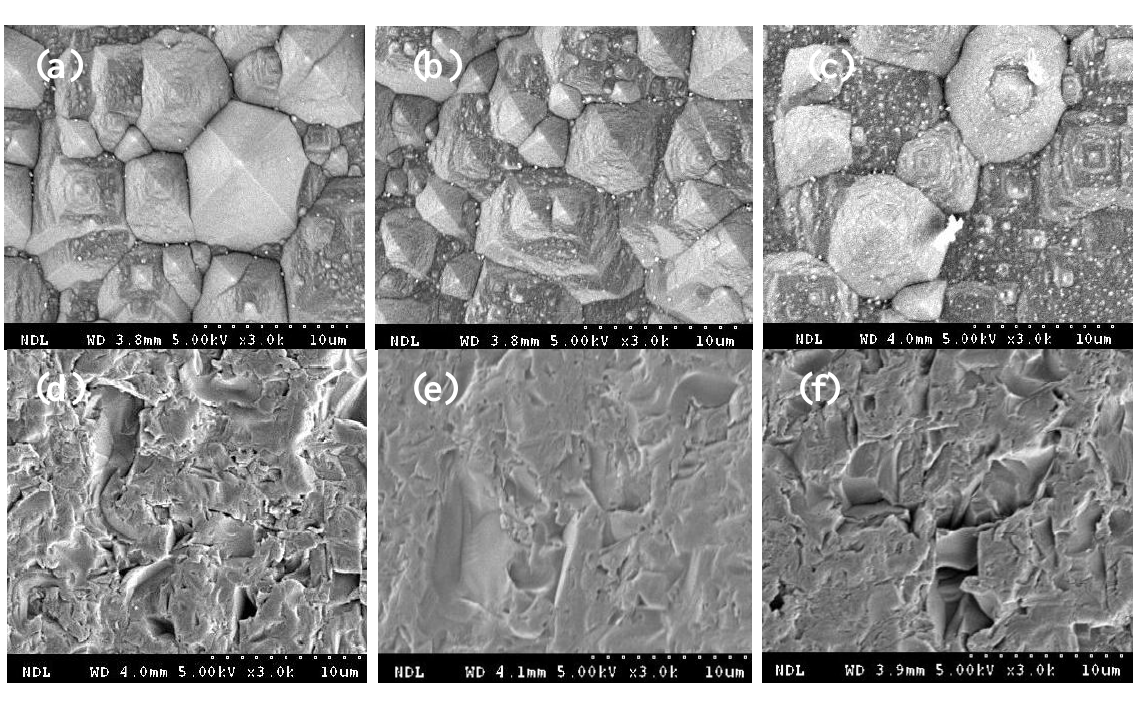
Figure 7. The SPTB layer/p-type Si(100) substrates were fired at ( a ) 10, ( b ) 20, ( c ) 40, ( d ) 60, ( e ) 80 and ( f ) 100 min, respectively. Then, all SPTB layer/p-type Si(100) substrates were textured in 1.7% KOH solution for 25 min. Finally, the SPTB layer/p-type Si(100) substrates were etched in mixed HCl/H O solution for 60 min. All surface morphologies 2 2 of the p-type Si(100) substrate after SPTB removal were detected by